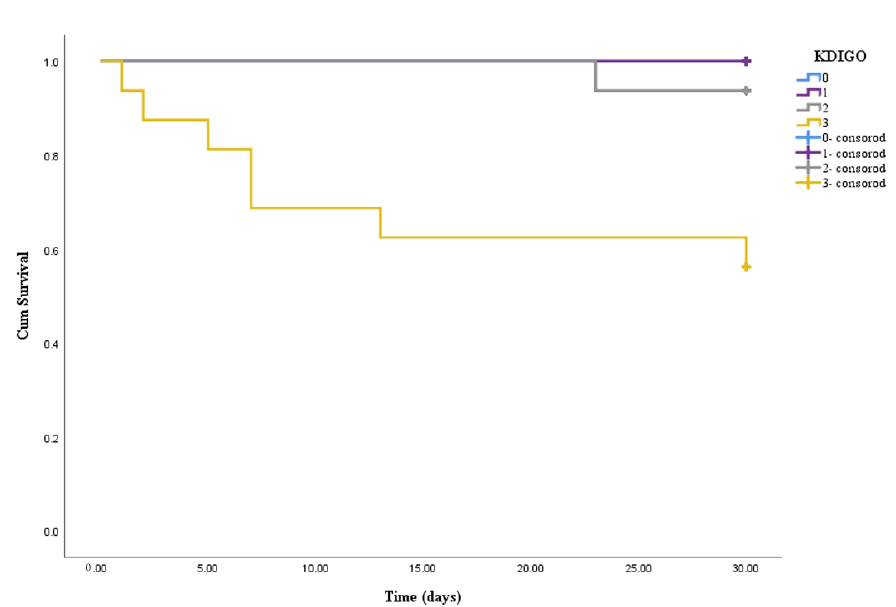
Figure 1. Impact of KDIGO stages on 30-day survival. Significant overall difference is observed ( p < 0.001 by log-rank test).